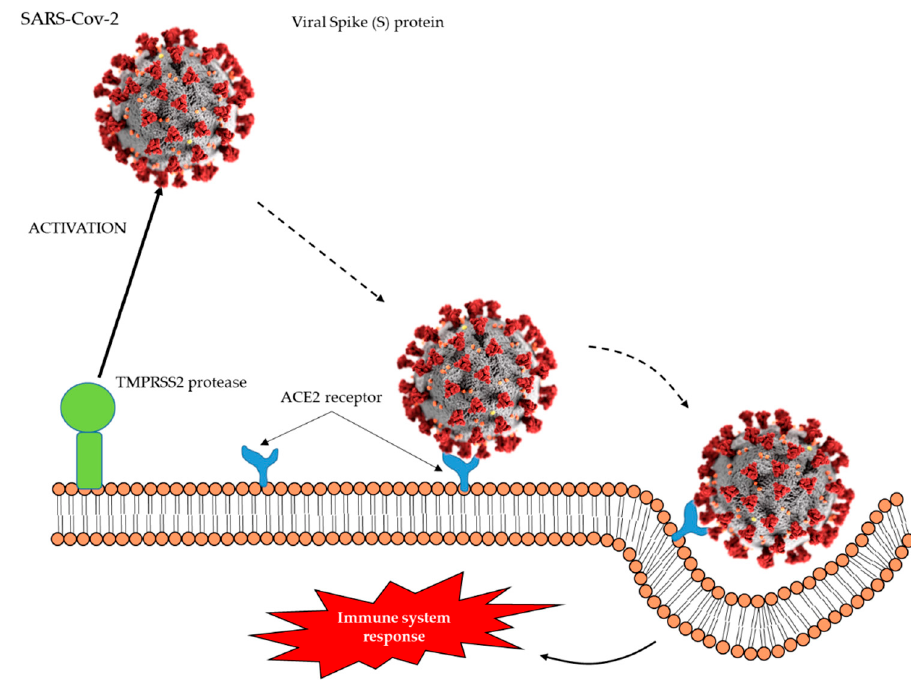
Figure 1. Severe acute respiratory syndrome coronavirus 2 (SARS-CoV-2) virus uses the angiotensin- converting enzyme 2 (ACE2) receptor to enter the host cell and the transmembrane protease serine 2 (TMPRSS2) for Spike (S) protein